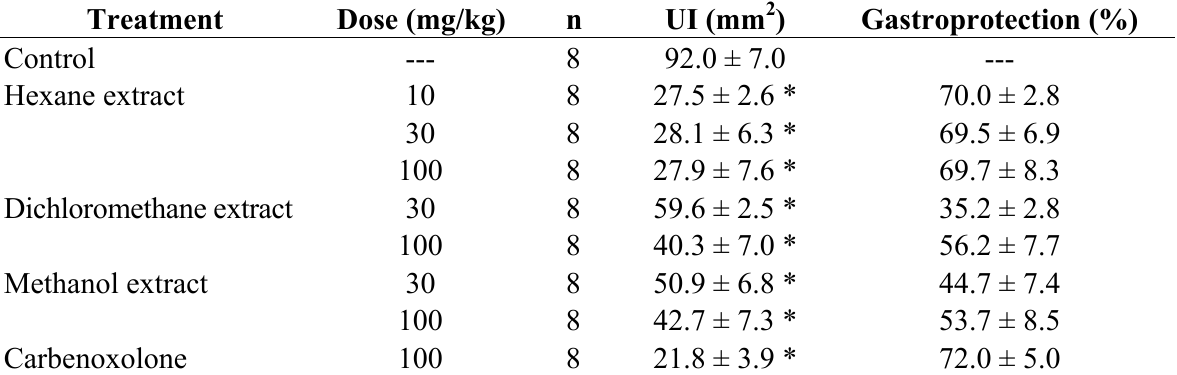
Table 1. Gastroprotective effect of H. suaveolens extracts on ethanol-induced ulceration in rats.